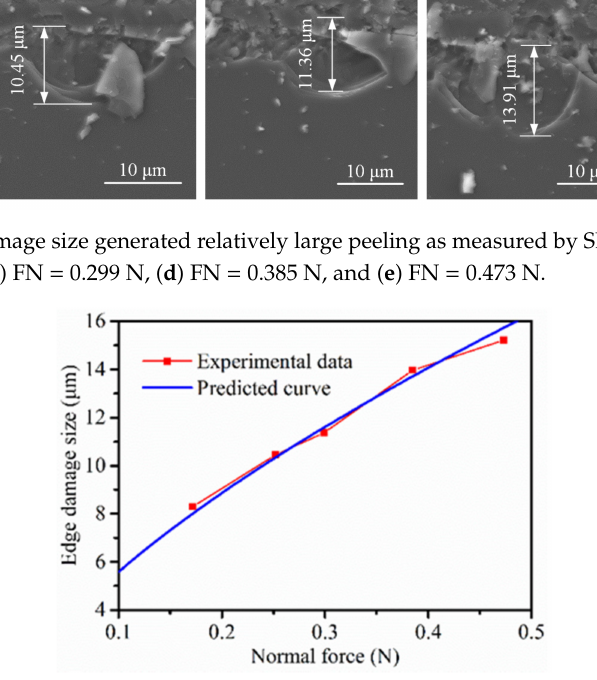
Figure 14. Comparison of predicted edge damage size and experimental results.